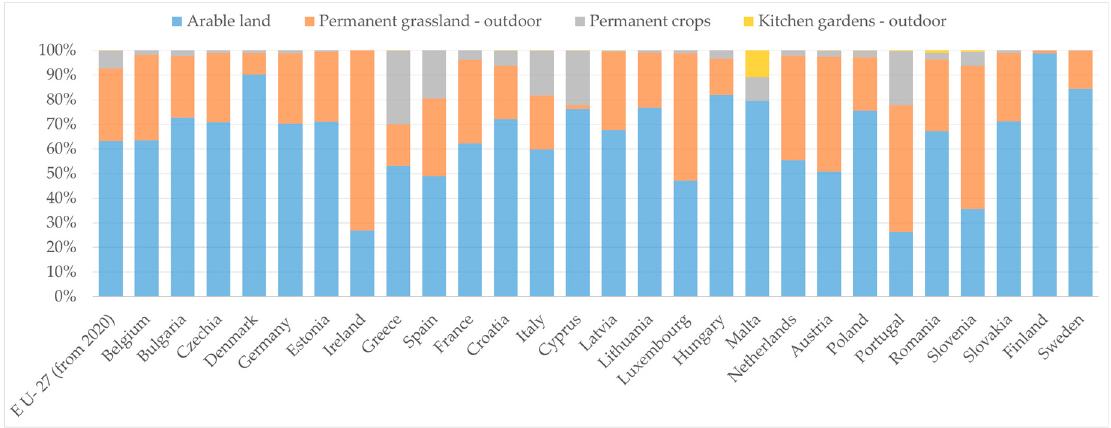
Figure 2. European Union UAA structure. Source: Authors’ calculation and representation, according to Eurostat (2020) data.